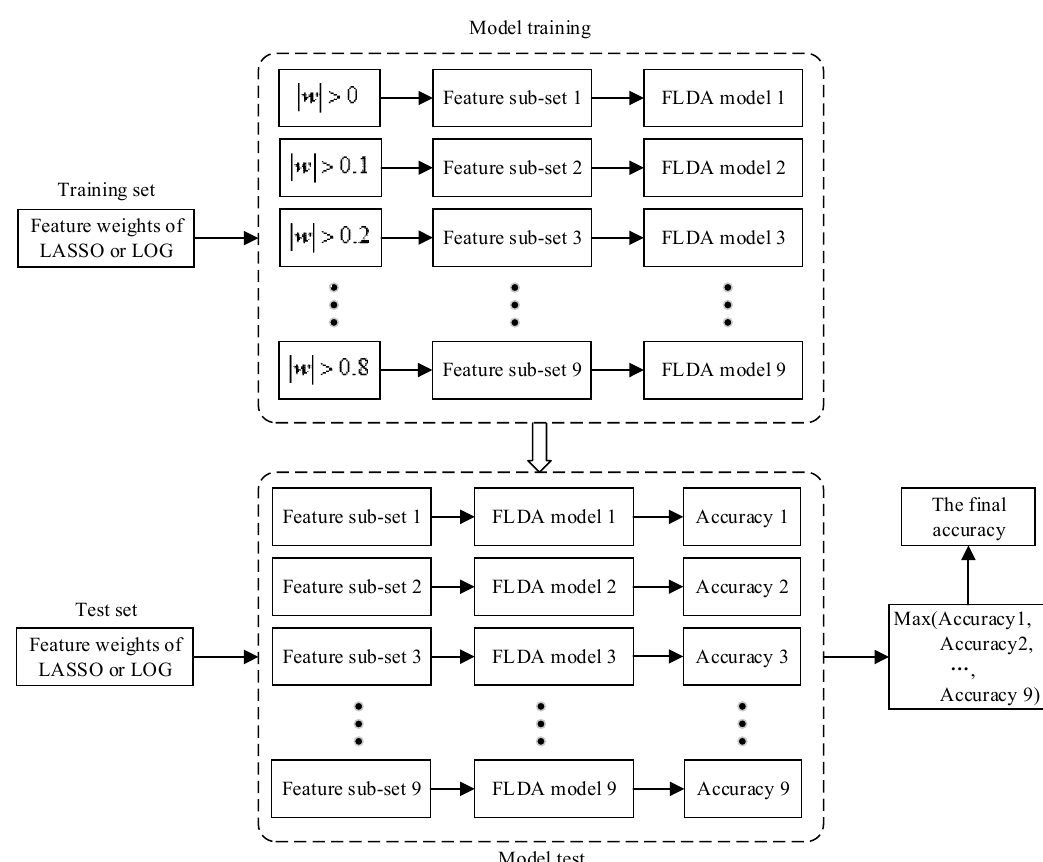
Figure 5. The processing flow of secondary feature selection and classification.